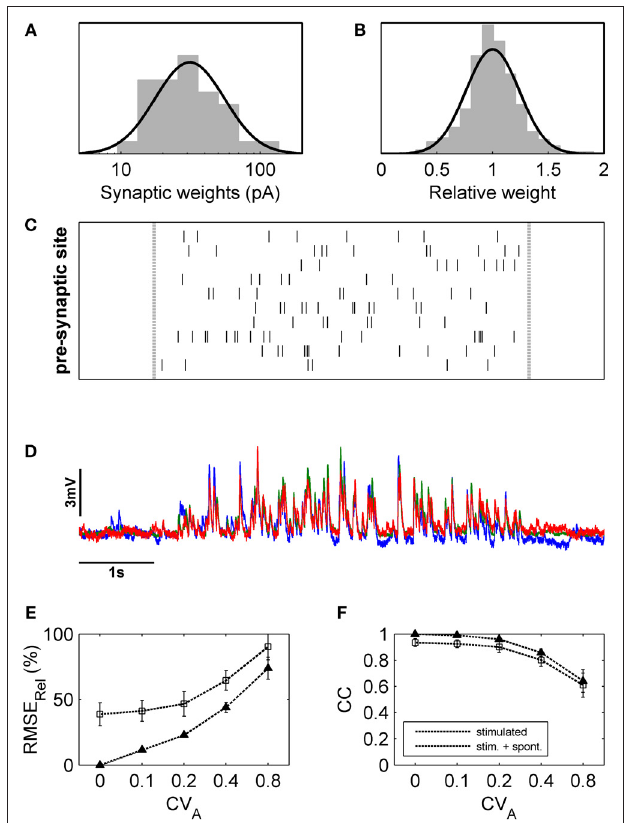
FIGURE 6 | Estimation of contributions of different sources of variability with the help of a linear model of synaptic integration. (A) Weights of individual synapses were randomly pulled from a log-normal distribution fi tted to the data from the single-shot experiments, and the amplitude of each modelled synapse was varied form trial to trial according to a Gaussian fi t to the relative amplitude distribution of the same data (B) . With these synapses, input patterns were simulated corresponding to those generated experimentally (C) , and the resulting simulated membrane potential fl uctuations (D) were analyzed in the same way. Varying the amplitude variability of the simulated synapses revealed that, with increasing CV , amplitude variability of the membrane potential fl uctuations A also increased markedly (E) while the CC decreased notably only for large values of CV (F) . A